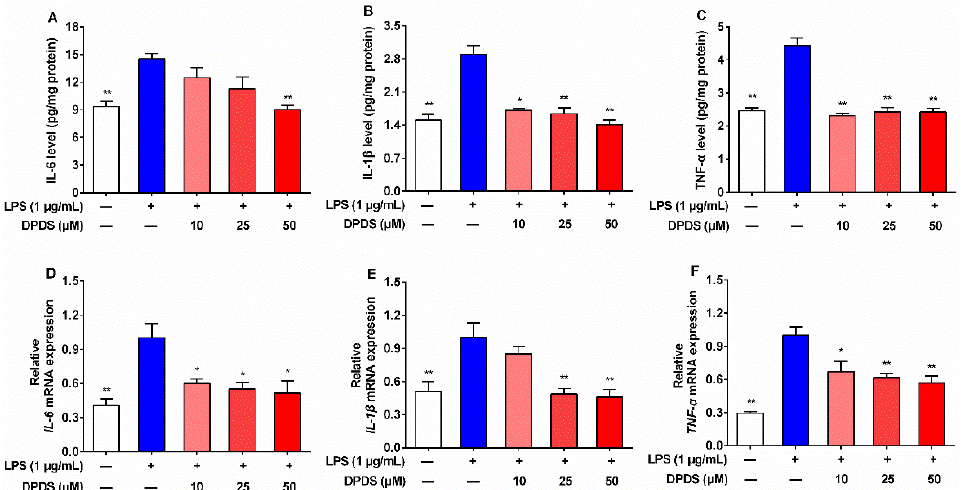
Figure 5. DPDS decreased intracellular contents and gene expression of inflammatory cytokines in LPS-treated HBZY-1 cells. HZBY-1 cells were incubated with LPS (1 µ g/mL) alone or in combination with indicated concentrations of DPDS for 24 h. ( A ) Intracellular IL-6 content. ( B ) Intracellular IL-1 β content. ( C ) Intracellular TNF- α content. The relative mRNA levels of IL-6 ( D ), IL-1 β ( E ) and TNF- α ( F ) expressed as fold of the LPS group. Values are presented as means ± SEM, n = 4. * p < 0.05, ** p < 0.01 versus the LPS group.